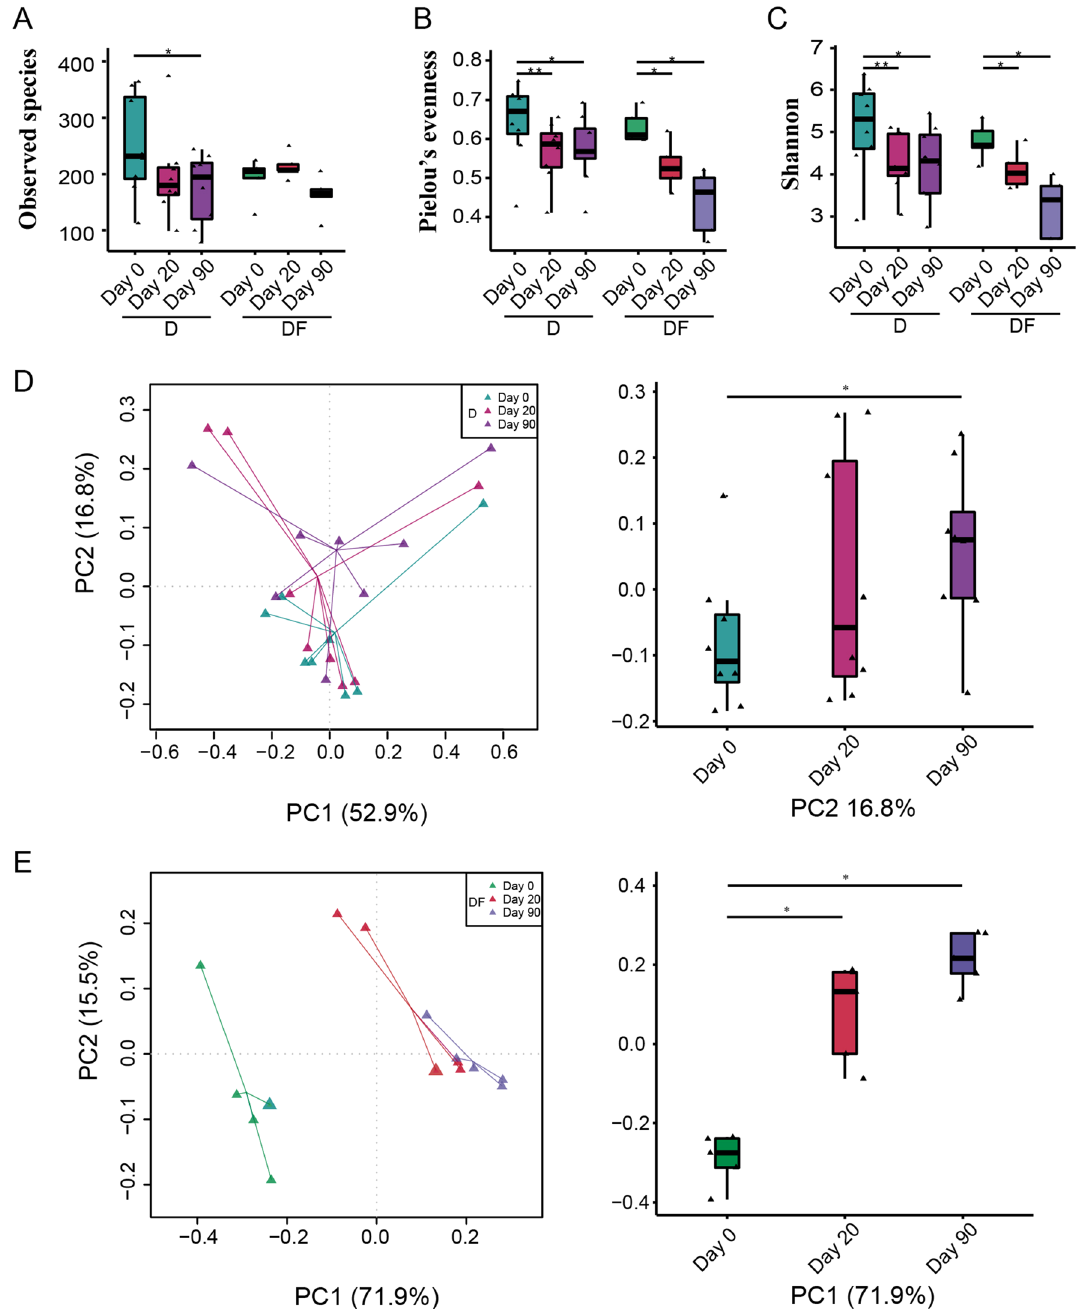
Figure 3. Gut microbiota diversity. Alpha diversity quantified by the ( A ) Observed species index, ( B ) Pielou’s evenness index, ( C ) Shannon index after rarefying to 3000 sequences. ( D ) Weighted Unifrac PCoA of gut microbiota based on the OTU data in D group. ( E ) Weighted Unifrac PCoA of gut microbiota based on the OTU data in DF group. *p < 0.05; **p < 0.01. Two-tailed Student’s t test for paired-samples was used in alpha diversity comparison. Two tailed Wilcox matched-pair signed-rank test was used in beta diversity